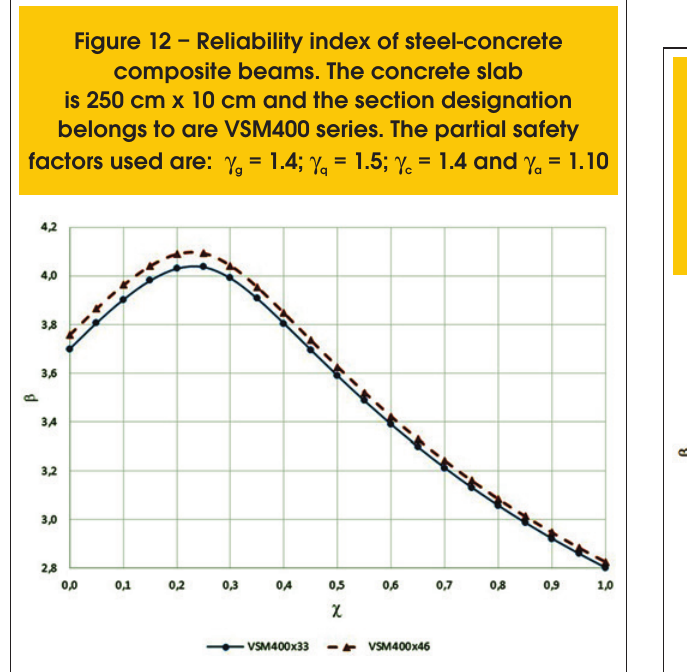
Figure 13 – Reliability index of steel-concrete composite beams considering two strength coefficients ( g = 1.1 and g = 1.15).